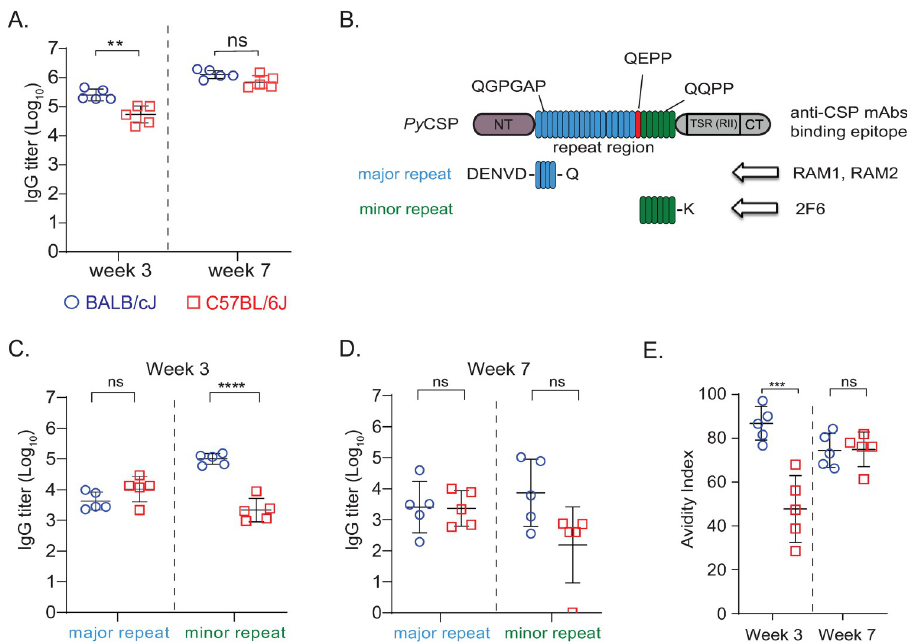
Fig 2. Comparison of antibody responses after immunization of Py CSP at week 3 and 7 time points in BALB/cJ and C57BL/6J mice. A. 6–8 weeks old female BALB/cJ (n = 5) (blue) and C57BL/6J (n = 5) (red) mice were intramuscularly immunized with 20 μ g of Py CSP with 20% adjuplex on weeks 0, 2 and 6 and the blood samples were collected on week 3 and week 7. ELISA was performed to analyze the Py CSP-specific total IgG titers. B. Cartoon representing the domain organization of mature Py CSP ectodomain. The N- and C-terminal domains are represented as NT and CT, respectively. The TSR (RII) domain is in CT. The major and minor repeats of the repeat domain are colored blue and green, respectively and their respective amino acid repeat sequences are illustrated. The QEPP amino acid sequence connecting the major and minor repeat regions is indicated in red. The binding epitopes of anti- Py CSP mAbs RAM1, RAM2 and 2F6 are indicated with arrows. C and D. Py CSP-specific IgG titers of Py CSP-immunized BALB/cJ (blue) and C57BL/6J (red) mice to the major and minor repeats at Week 3 (2C) and Week 7 (2D) were analyzed . E. The avidity of the Py CSP-immunization elicited antibodies to the Py CSP antigen at weeks 3 and 7 in BALB/cJ (blue) and C57BL/6J (red) mice were analyzed. Avidity index is calculated by (AUC of NH 4 SCN wells)/ (AUC of PBS wells) � 100. Data analyzed by Two-way ANOVA and p values were obtained by Tukey’s multiple comparison test. ���� p < 0 . 0001; ��� p < 0 . 0004 �� p < 0 . 005; ns- not